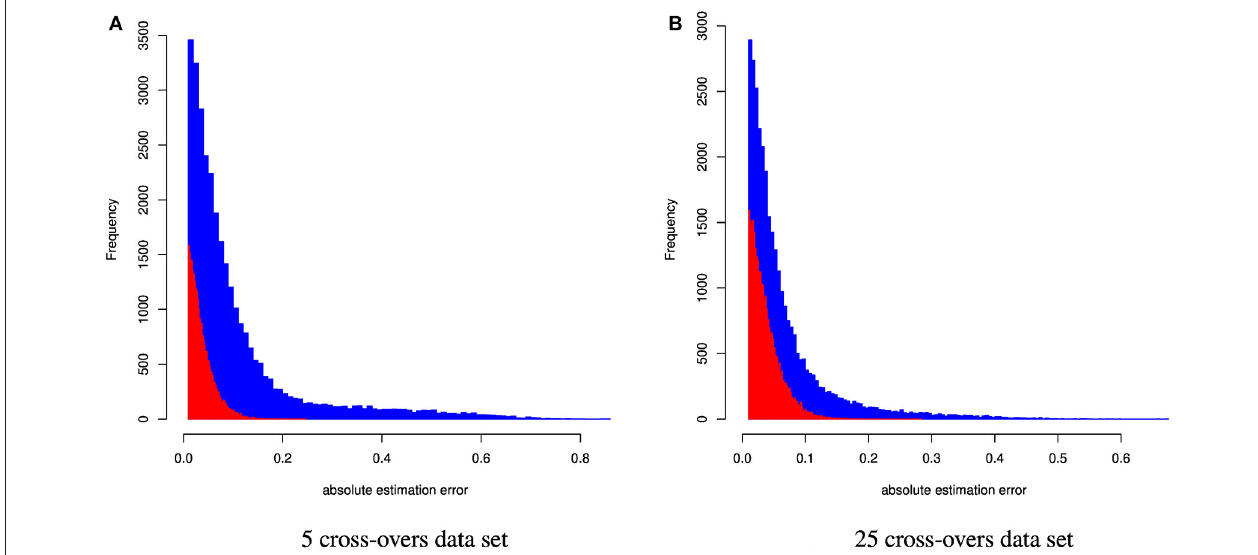
FIGURE 3 | Distribution of the absolute estimation error from CGR (red) and ADMIXTURE (blue) for the cattle data set generated using 5 and 25 cross-overs and 4,022 genetic markers.